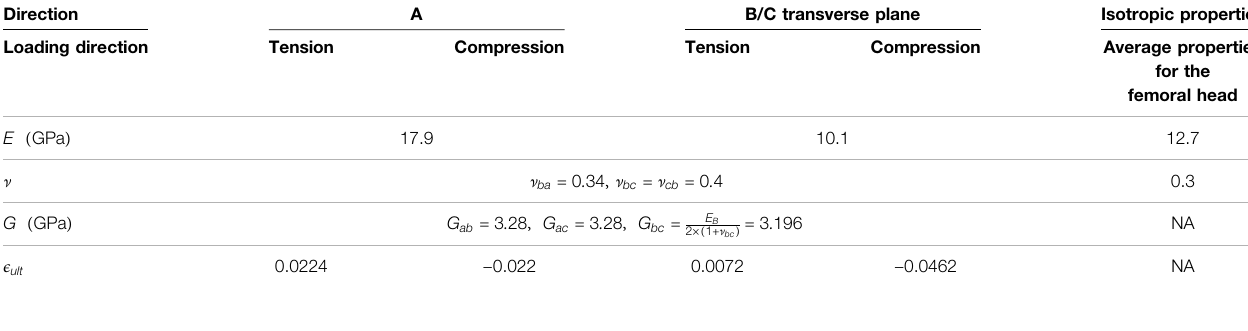
TABLE 1 | Mechanical properties used for the healthy 40 years old subject. See Figure 1C for material directions.